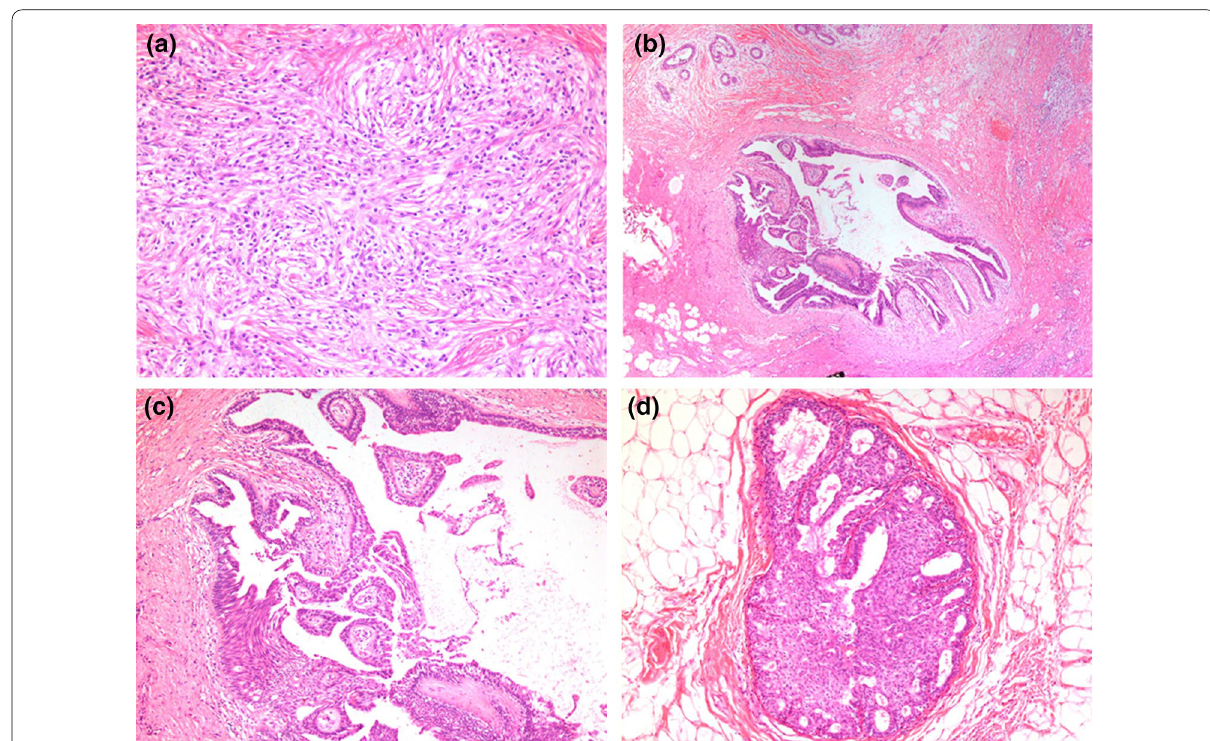
Fig. 2 a High-power magnification of breast lump biopsy showing spindle cell lesion arranged in storiform pattern dissecting collagen fibers. No nuclear atypia, necrosis, or mitosis is seen. (H&E 400). b Low-magnification view of breast tissue showing large lactiferous duct with a papillary × lesion exhibiting papillary structures with central fibrovascular cores.